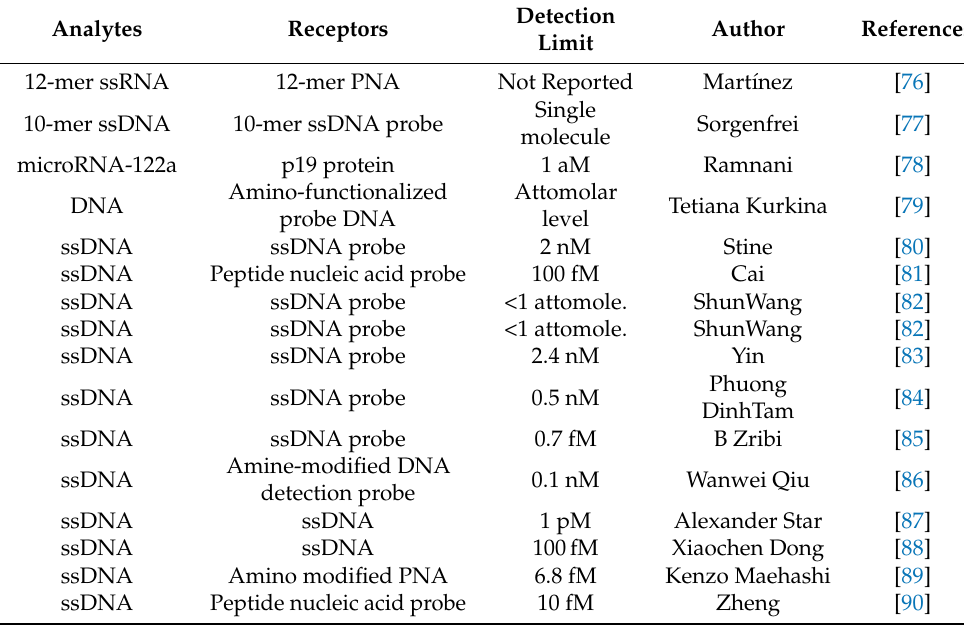
Table 3. The research on CNTFET for Nucleic acid-based analyte detection.